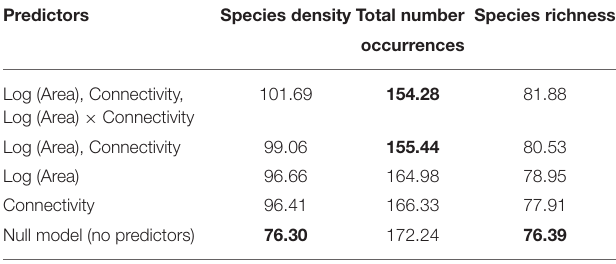
TABLE 4 | Akaike Information Criterion corrected for small sample sizes (AICc) assessed for the models estimated for species density, total number of occurrences and species richness (for 44 occurrences) as function of the different combinations of the predictors Log (Area) Connectivity and Log (Area) x Connectivity.